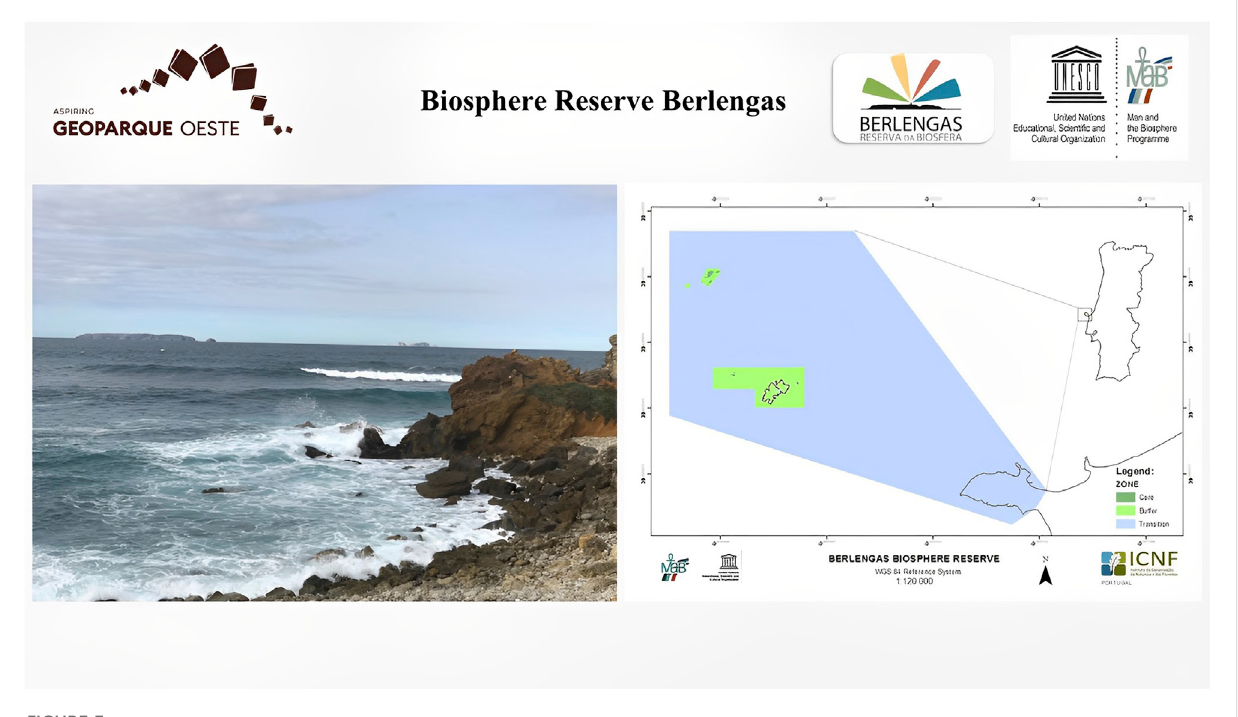
FIGURE 3 Berlengas-Peniche biosphere reserve. Source: produced by the